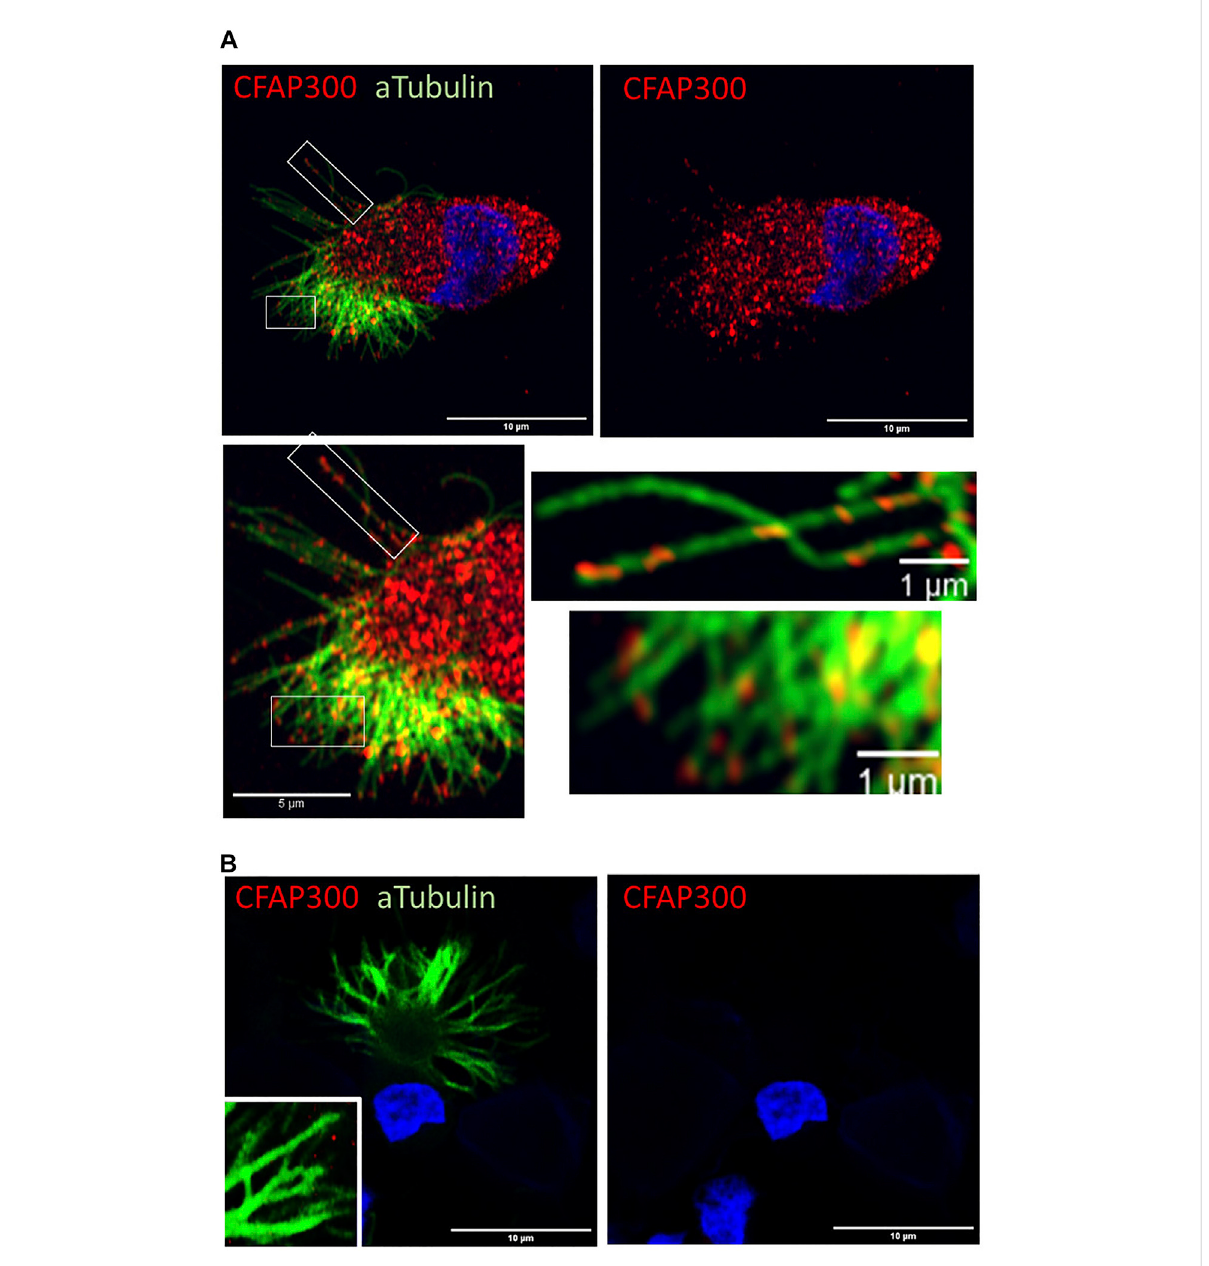
FIGURE 4 CFAP300istransportedalongthemotileairwayepithelialcilium. (A) .InnormalairwayepithelialcellsmostoftheCFAP300proteinislocalizedin the cytoplasm, but some of the protein appears to be transported into the cilium. (B) . No CFAP300 staining was detected in the patient airway epithelial